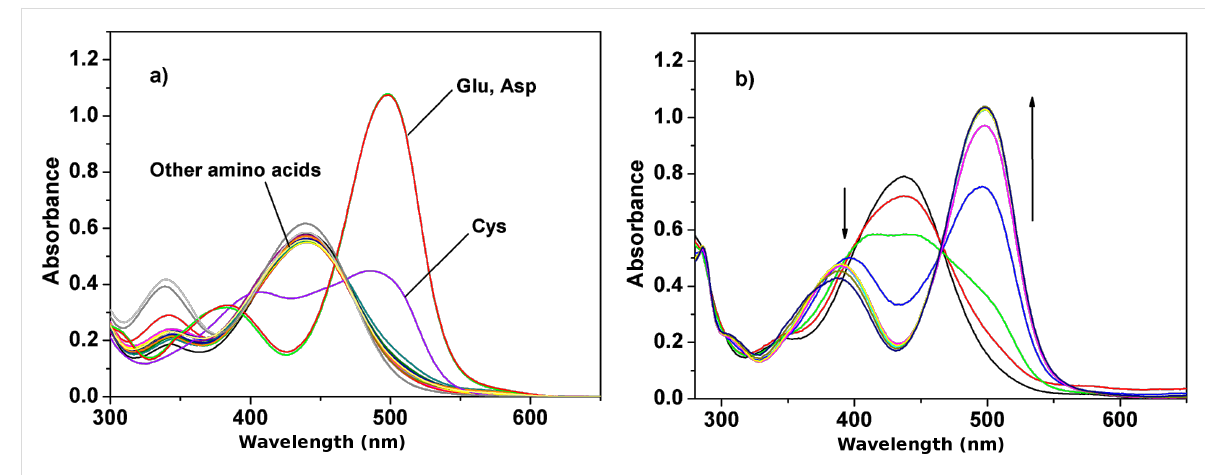
Figure 4: Changes in UV–vis spectra of 1 (5.0 × 10 − 5 M) in CH 3 CN/H 2 O (1:1, v/v) after addition of: (a) 25 equiv of Gly, Ala, Val, Leu, Iso, Phe, Thr, Glu, Asn, Met, Ser, Pro, Trp, Lys, Arg, His, Tyr, Glu, Asp and Cys; (b) 0, 1, 2, 3, 4, 5, 8, 10, 20, 50, 100 equiv of Asp.